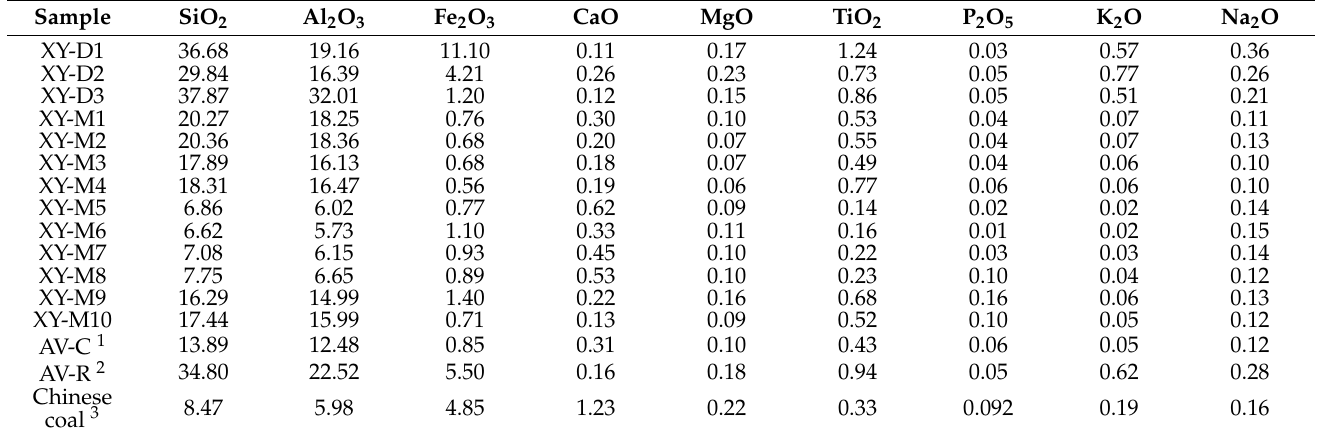
Table 3. Concentrations of major and minor element oxides (%) in the No. 9 coal and related roof samples (on whole coal/rock basis) from the Xinyuan